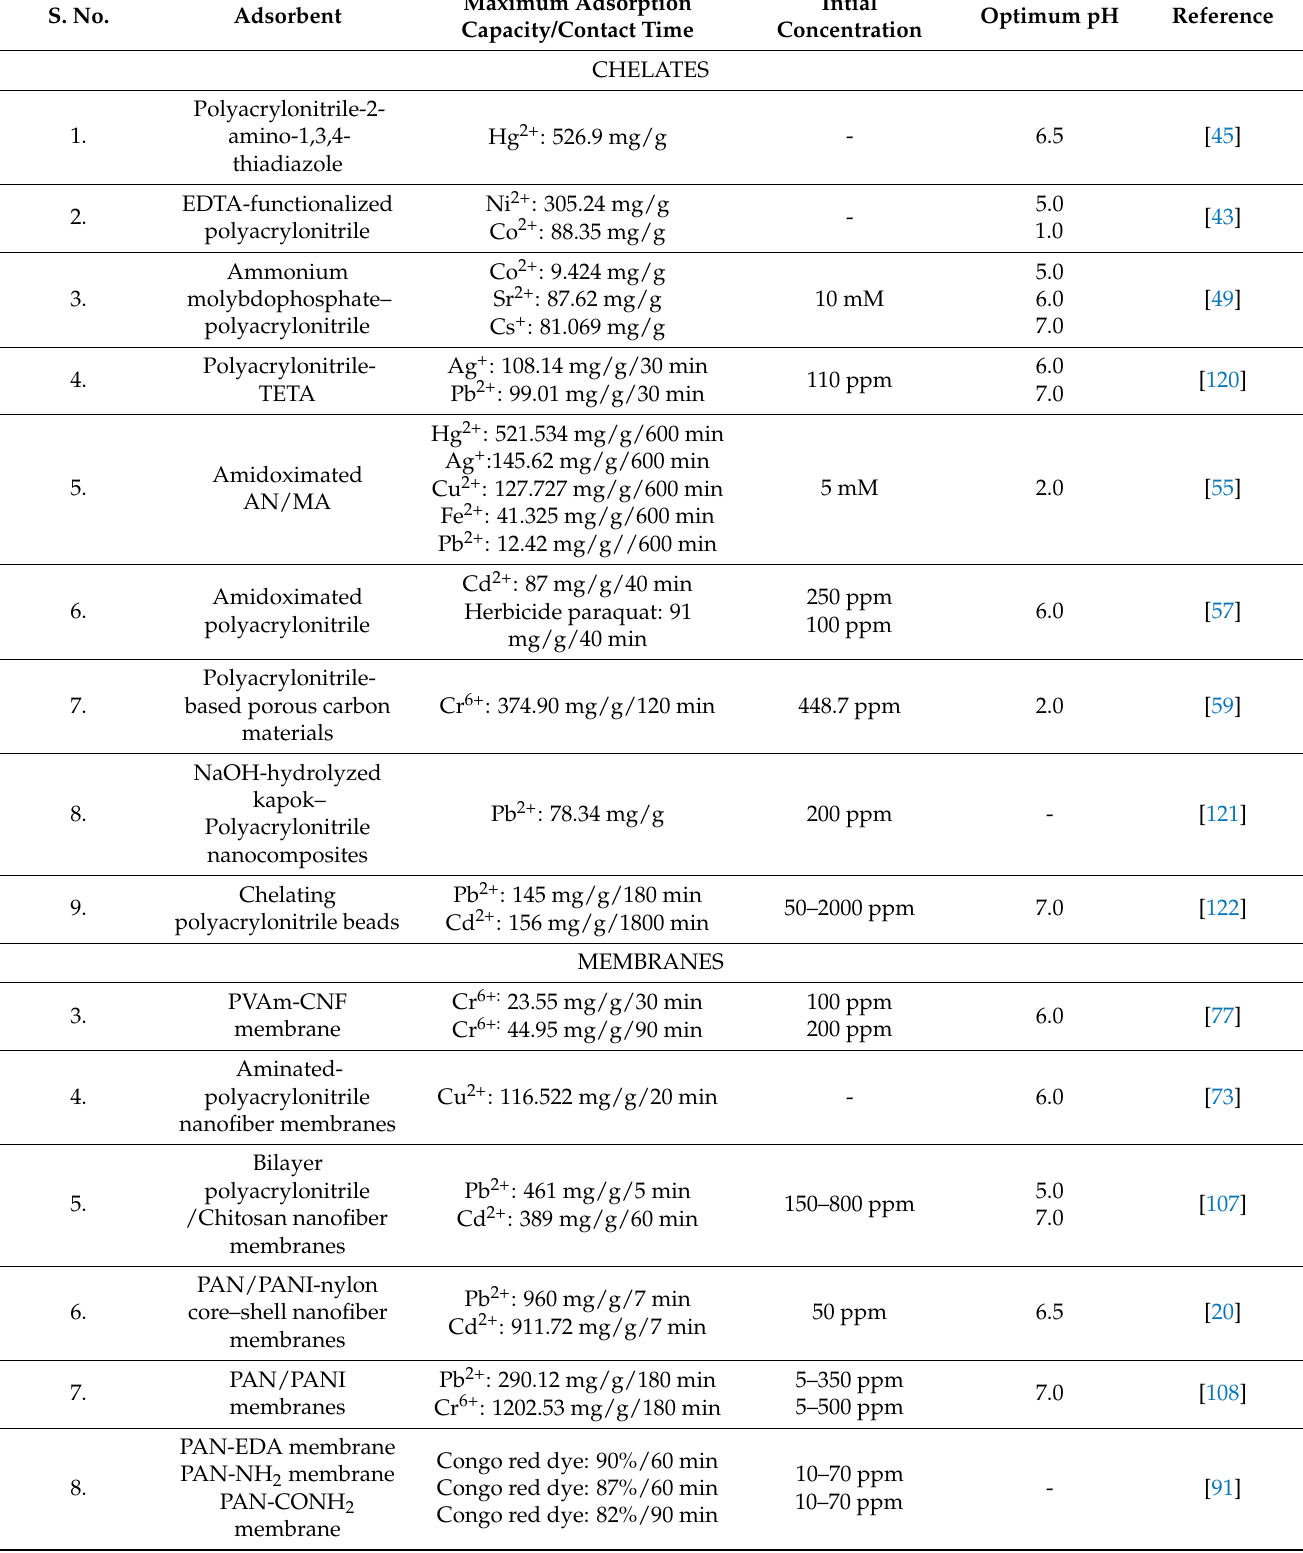
Table 1. Performance overview of various polyacrylonitrile-based